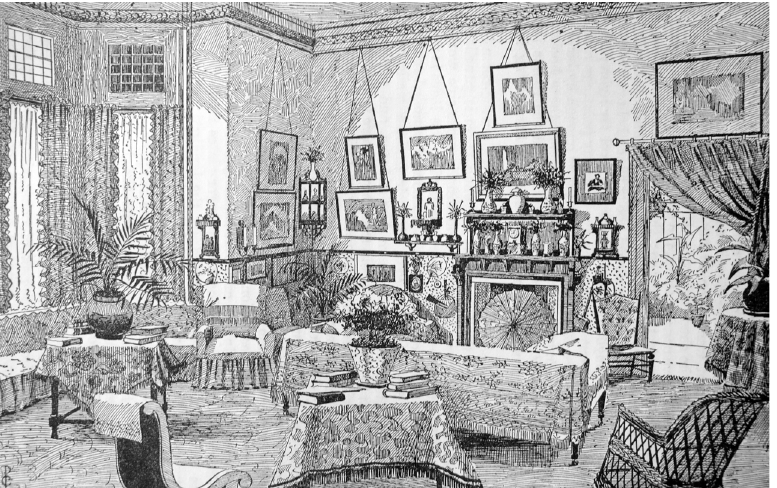
Figure 6: ‘Drawing-room at Gable-end, Shortlands’ (Panton, 79. Author’s collection).